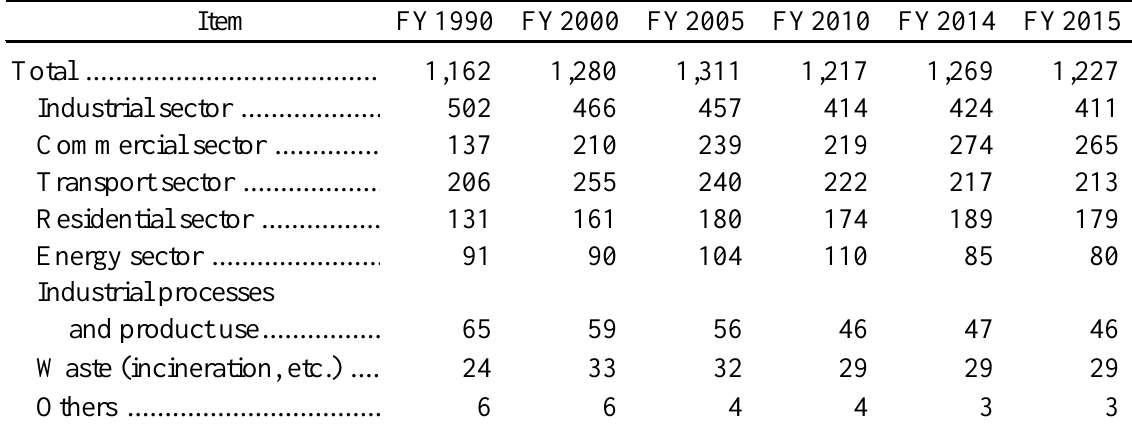
Breakdown of Carbon Dioxide Emissions